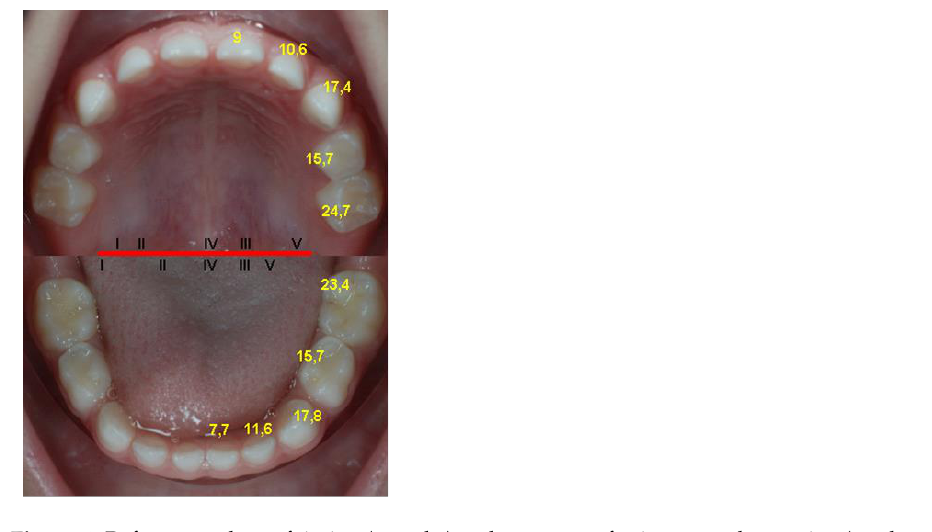
Figure 4. Reference values of timing (months) and sequence of primary teeth eruption (tooth numbers of the upper and lower jaw quadrant, in relationship to the red line) in our sample.